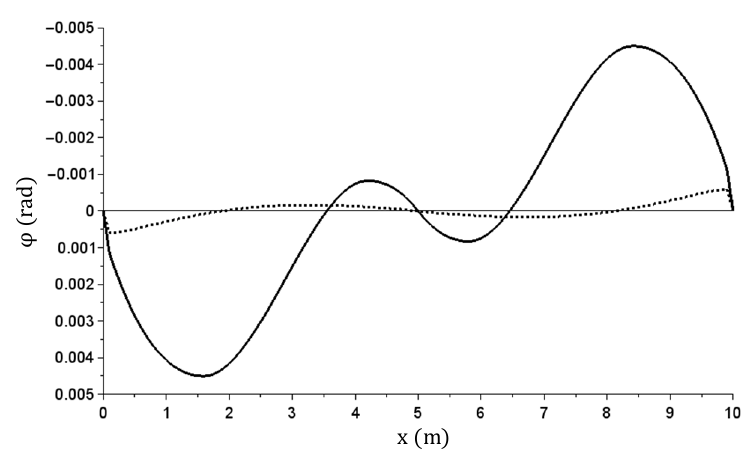
Figure 22. The φ(x) (rad) angle of rotation graph—at maximum and after relief.